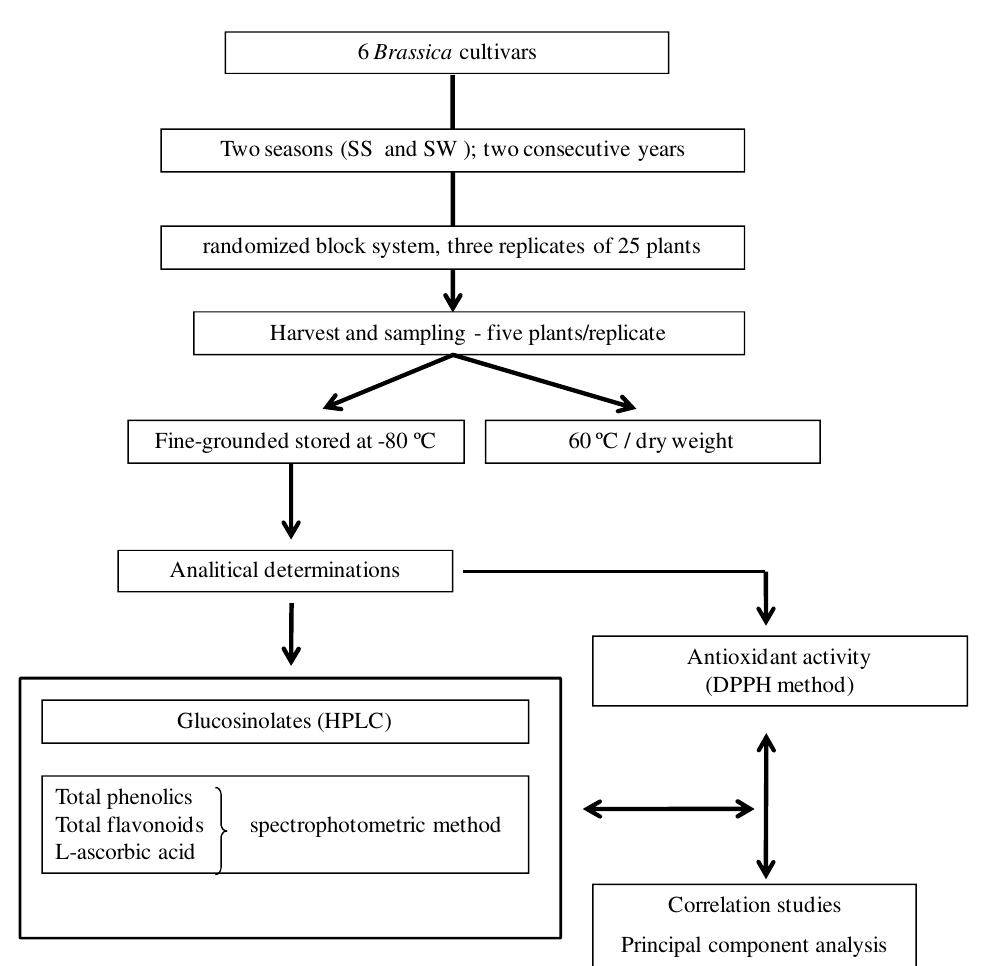
Figure 3. Main steps of experimental design applied in this